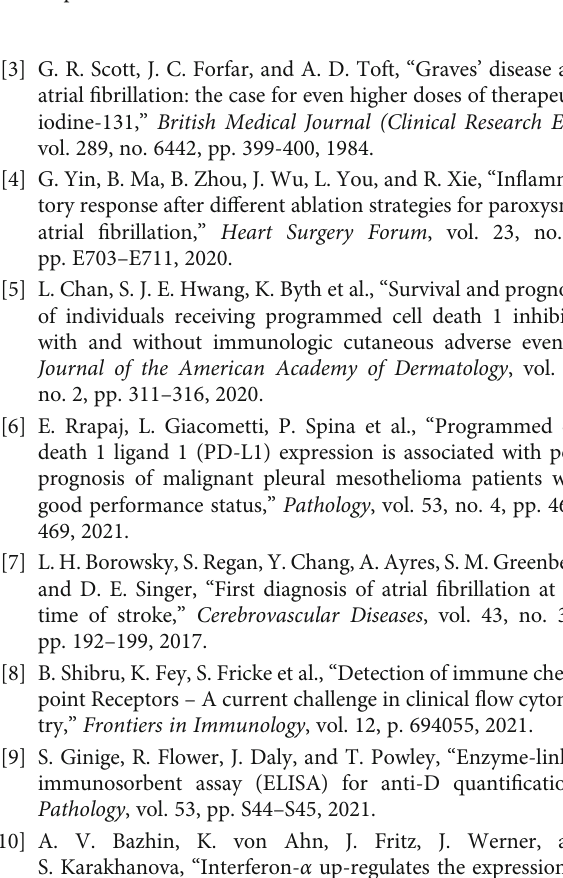
Figure 2: Kaplan-Meier curve analysis of the risk of stroke in patients with AF with di ff erent SIS